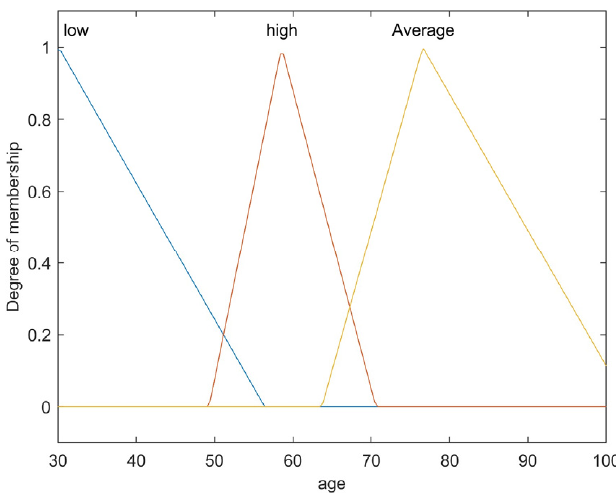
Figure 2. Membership function of age as input variable.